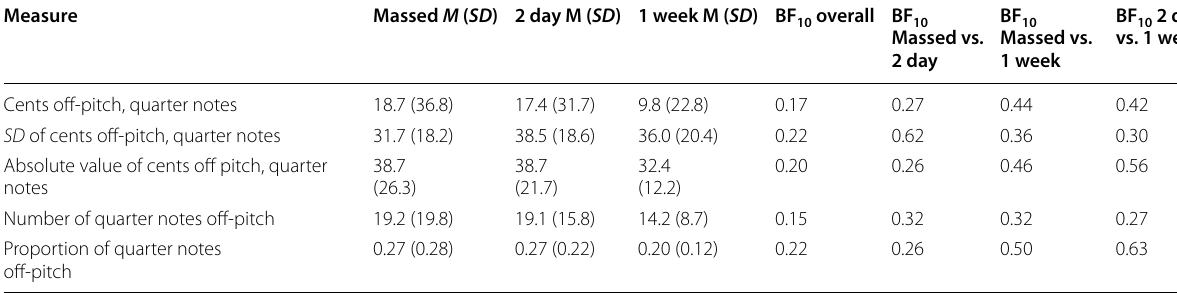
Table 8 Learning outcome: notes (test 1.3), for massed, 2-day, and 1-week ISIs Measure